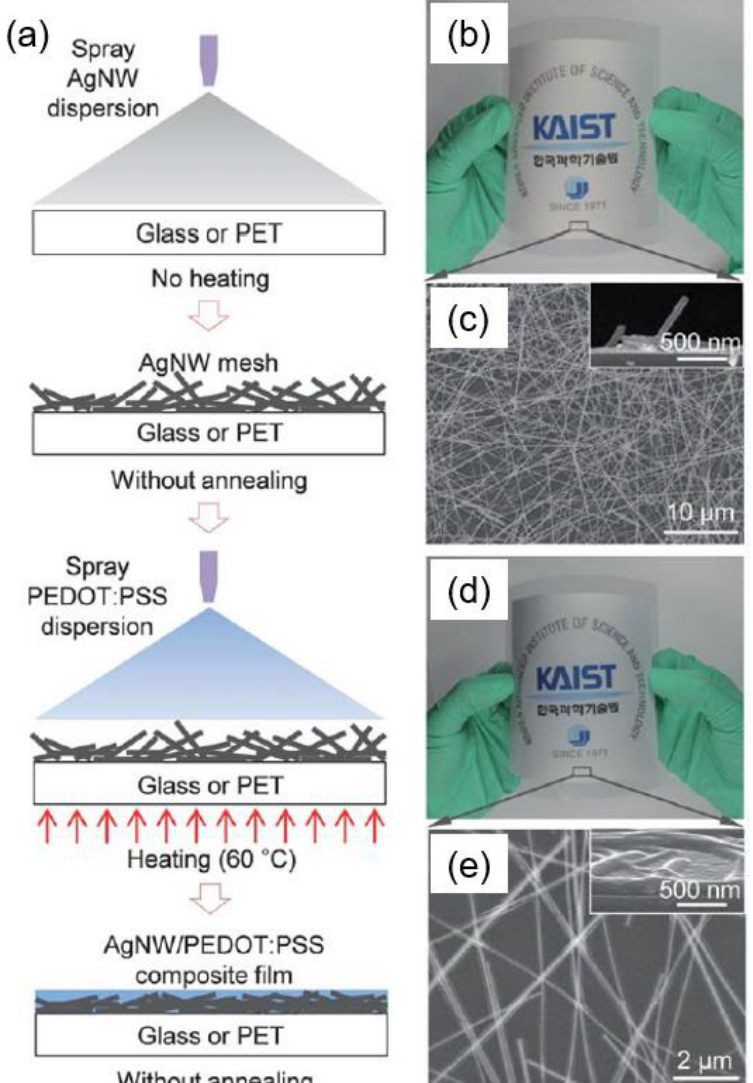
Figure 6. ( a ) Fabrication scheme for Ag NW–PEDOT:PSS composite electrodes. ( b ) Photograph of Ag NW mesh deposited on a PET substrate. ( c ) SEM image of Ag NW mesh with homogenous NW density. (Inset: cross-section view). ( d ) Digital photograph of Ag NW–PEDOT:PSS composite film. ( e ) SEM image of Ag NW mesh embedded in the PEDOT:PSS film. Reproduced with permission from [19]. Copyright 2013 Royal Society of Chemistry.